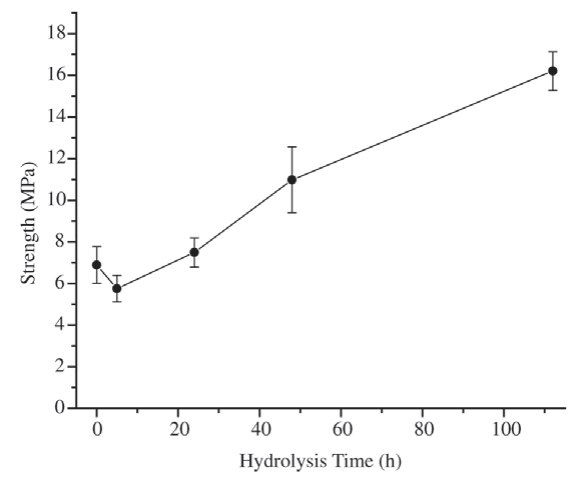
HPO ) hydrolysed for different 2 4